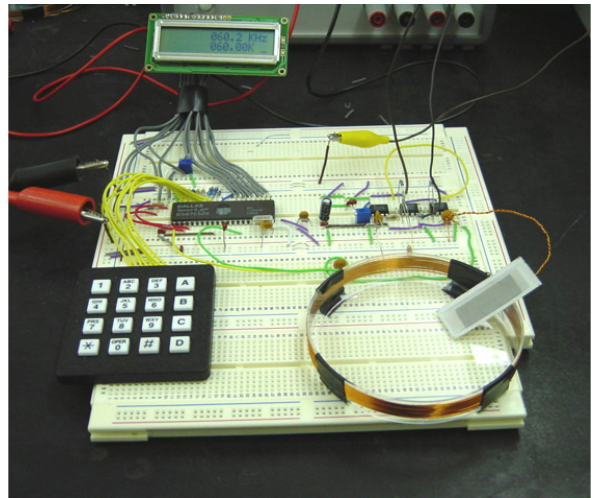
Figure 6. The electronics of a time-domain system using only one coil for excitation and receiving. The resonant frequency of the sensor is determined via frequency counting using a Dallas Semiconductor Corporation DS87C520 microcontroller.